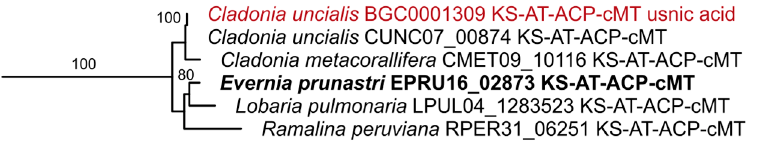
Figure 6. Supported clade containing the gene MPAS (methylphloroacetophenone synthase) of Cladonia uncialis (MIBiG-ID BGC0001309) putatively associated with usnic acid biosynthesis. For the complete KS tree see Figure S1.